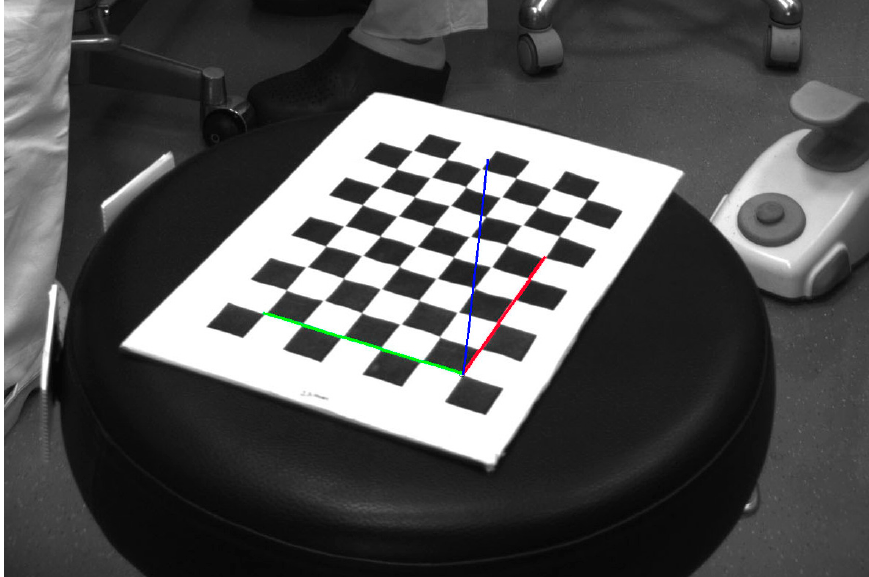
Figure 6. A checkerboard placed on a horizontal plane to get a global reference system; it is referenced as “ground”; using this set of axes we can consider the role of gravity in each limb posture.